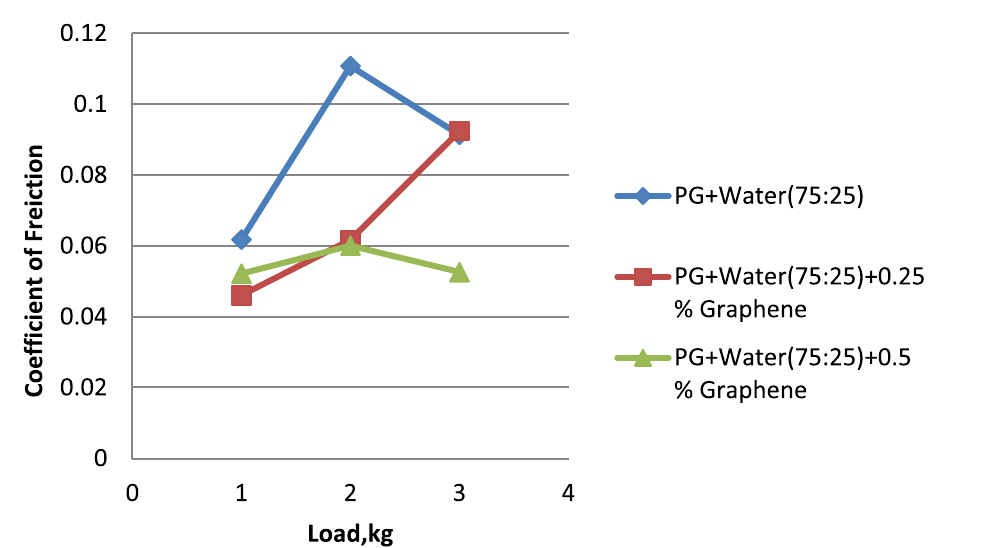
Figure 8. Load vs. coefficient of friction for propylene glycol